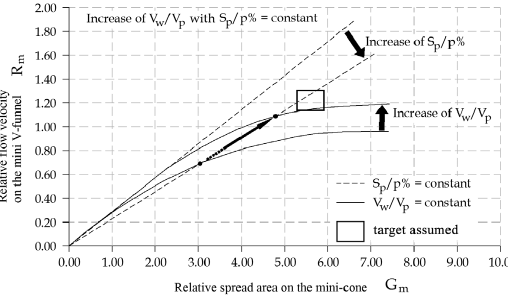
Figure 2. Changes in the workability parameters with the increase of V /V , keeping S /p% constant 5 . w p p